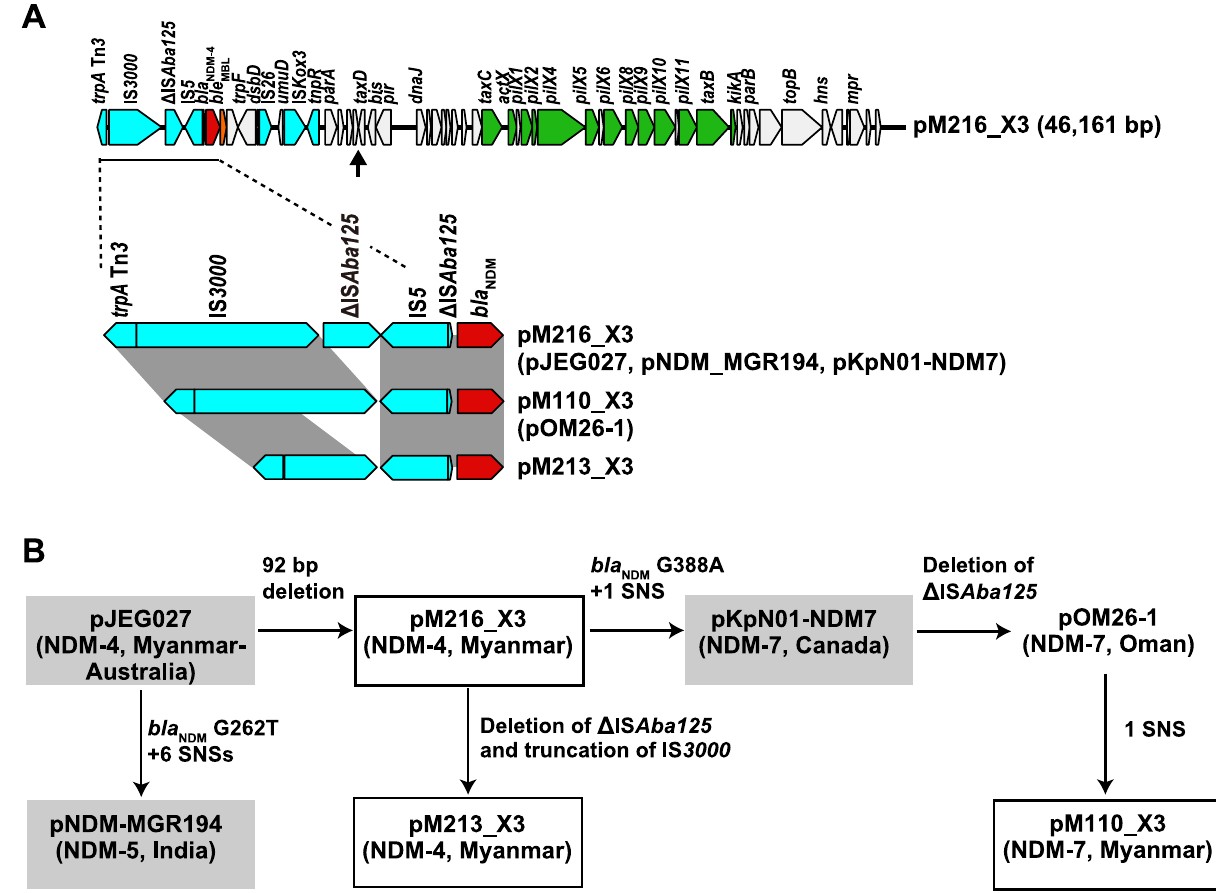
Fig 3. IncX3 plasmids harboring bla NDM . (A) Schematic representation of the bla NDM-4 plasmidpM216_X3and comparison of the genetic context of bla NDM in IncX3 plasmids. Genes are indicatedin colors as definedin Fig 2, except that genes involvedin conjugaltransfer are depictedin green. A 92-bp deletionthat is found in pM110_X3,pM213_X3, pM216_X3, pKpN01-NDM7, and pOM26-1 is indicatedby the arrow. (B) Evolutionary relationshipof fully sequencedIncX3 plasmidsharboring bla NDM as inferred from genetic variances.EncodedNDM variants are shown in parenthesesalong with geographical origin. The plasmidsidentified in this study are boxed. pJEG027,